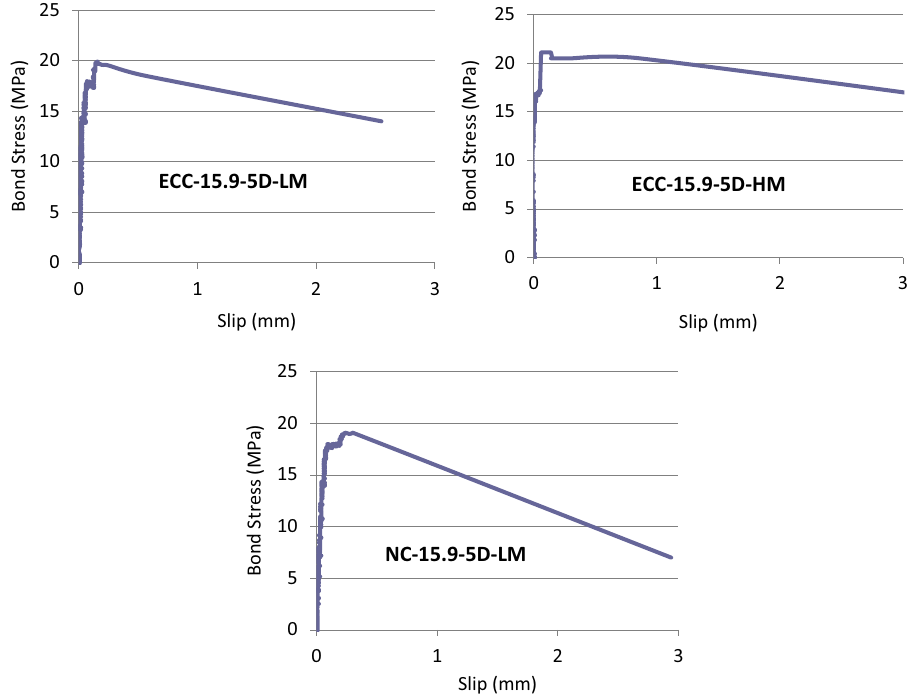
Fig. 7 Typical bond-slip curves from the beam tests.